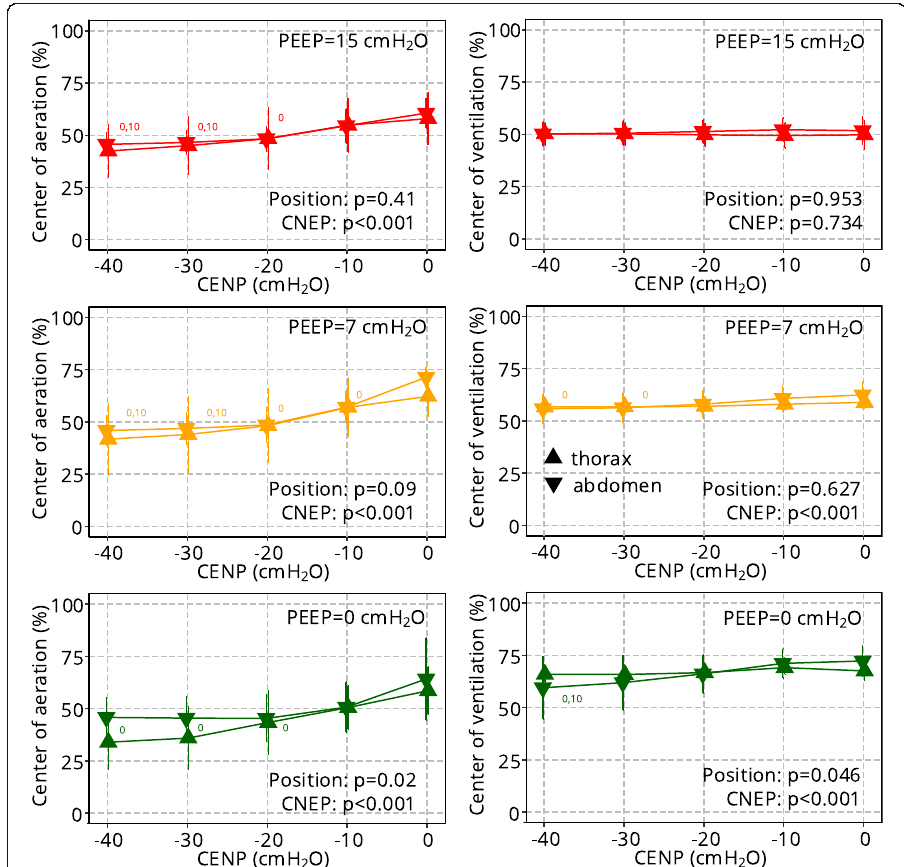
Fig. 3 Arterial oxygenation (PaO 2 , left) and cardiac output (CO, right). Legend: CENP, continuous external negative pressure; PEEP, positive end-expiratory pressure. Triangles indicate different shell positions (abdomen and thorax), colours represent different PEEP levels, super-posed numbers indicate significance ( P < 0.05) of the respective CENP level compared with the CENP level of the number and stars indicate difference between both